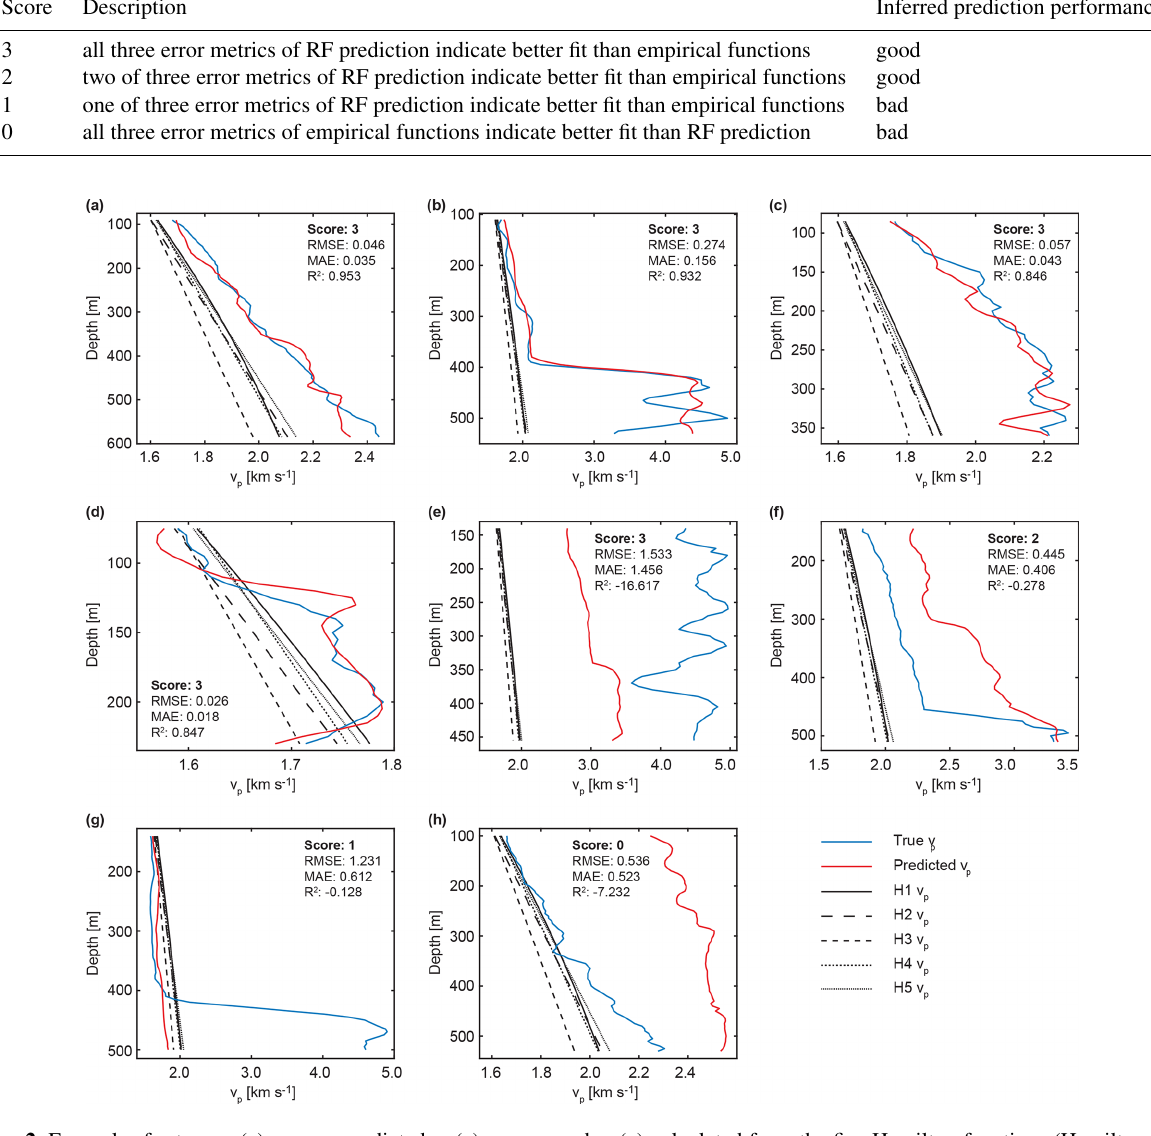
Figure 2. Examples for true v p (z) curves, predicted v p (z) curves, and v p (z) calculated from the five Hamilton functions (Hamilton, 1985) used in model evaluation. Panels (a) – (d) shows well-predicted v p (z) curves of score 3, (e) lower-quality prediction of score 3, (f) score 2, and (g) – (h) bad predictions of scores 1 and 0. See Sect. 2.3 for a description of H1 to